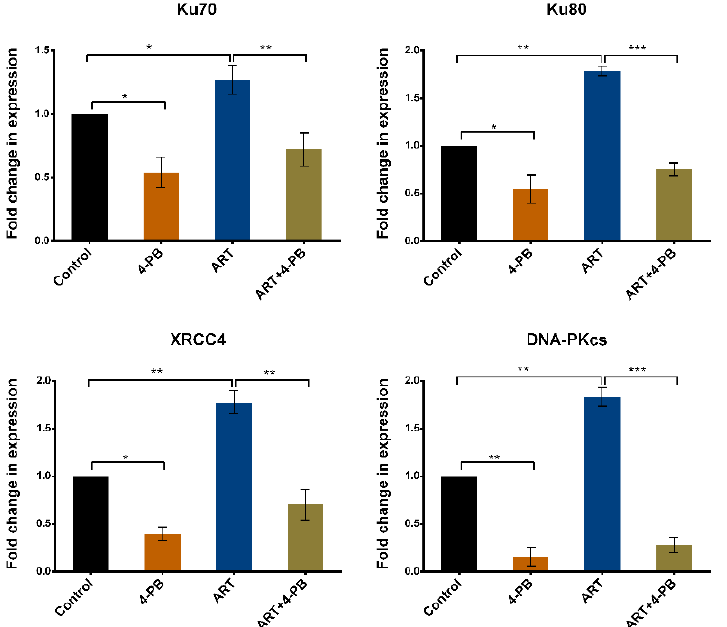
Figure 5. Expression analyses of DDR pathways. ( a ) mRNA expression levels of DDR elements of the NHEJ pathway. Ku70, Ku80, XRCC4 and DNA-PKcs were assessed using qPCR ( n = 3). Statistically significant values were taken as * p < 0.05, ** p < 0.01 and *** p < 0.001.